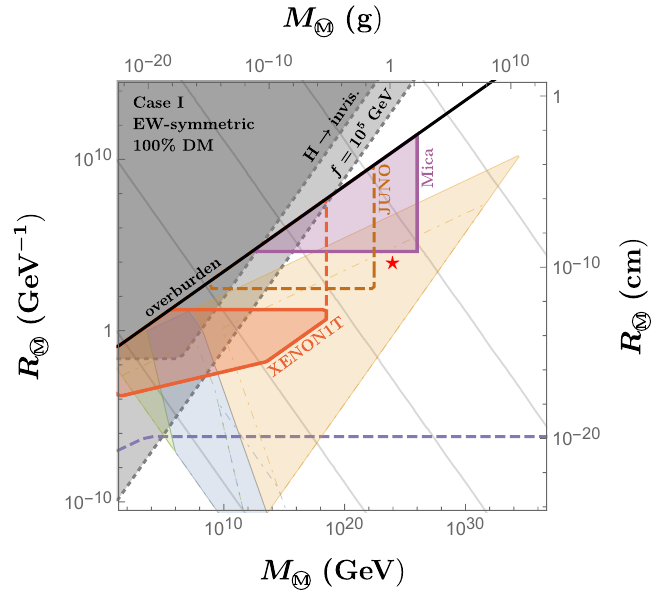
Figure 5 . Constraints on monopoles with EW-symmetric cores, Case I above, assuming they make up 100% of DM. These are overlaid onto several features from (cid:12)gure 4: the regions \A,B,C," the f = 10 5 GeV dotted gray line, the Kibble-Zurek+annihilations purple dashed line, and the light gray contours of g . The red shaded region is excluded by singlet-hit elastic scattering cross section constraints from XENON1T [50]. The broader unshaded region within the red dashed line gives rise to multi-hit events at XENON1T, requiring a dedicated search. The brown dashed line shows the JUNO [53] sensitivity to multi-hit events [11]. The purple shaded constraint comes from the absence of signals in mica [54, 55]. The black line shows where Earth and atmospheric overburden shielding prevents DM from making it to the detector. The gray shaded regions above the dotted lines in the top left show where EW symmetry restoration in the core is impossible because of limits on (cid:21) (cid:30)h from decoupling of the dark sector (lighter shading) and Higgs invisible decays [49] with (cid:21) (cid:30) = g 2 (darker